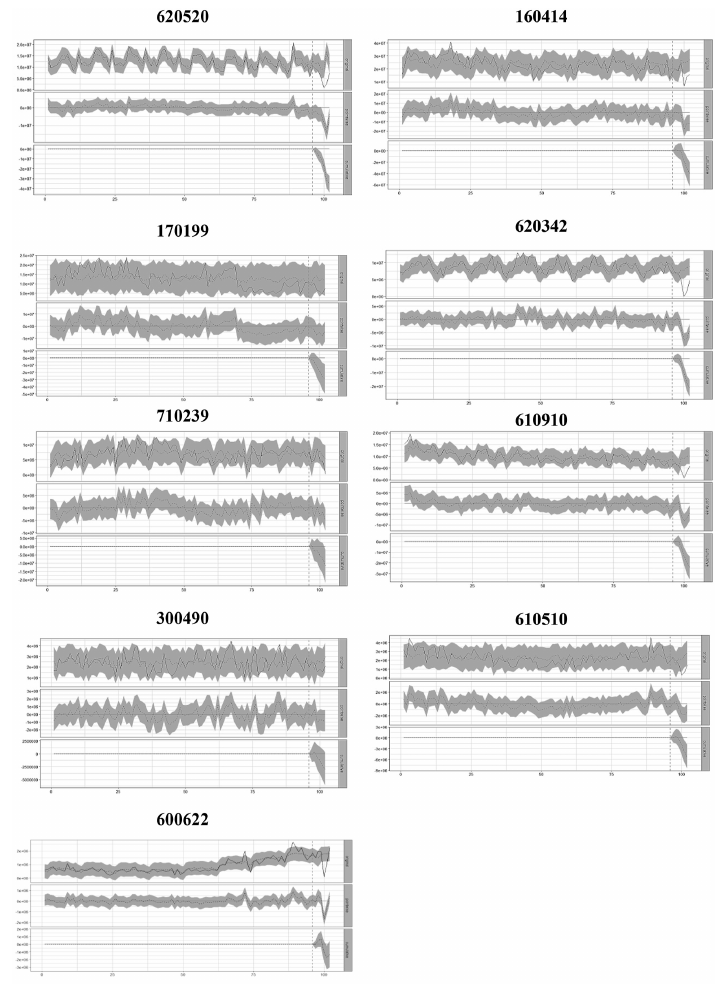
Figure A5. Bayesian posterior distribution graphs for the impact of COVID-19 pandemic on